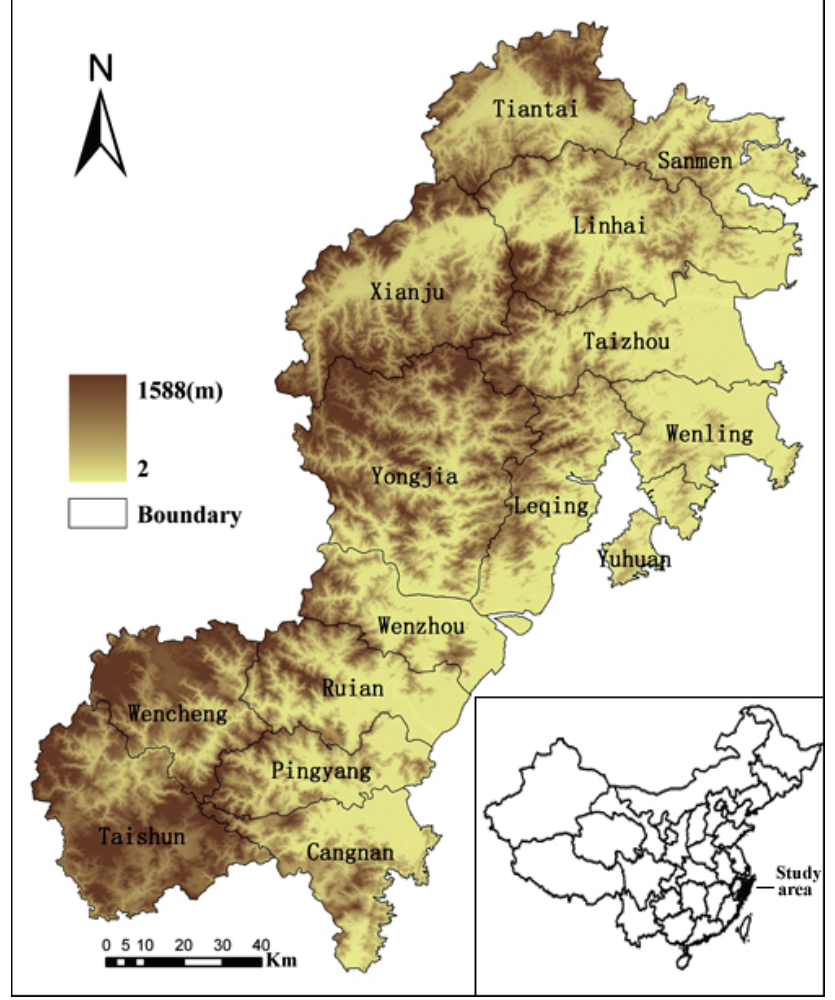
Figure 1. Location of the Wen-Tai region,